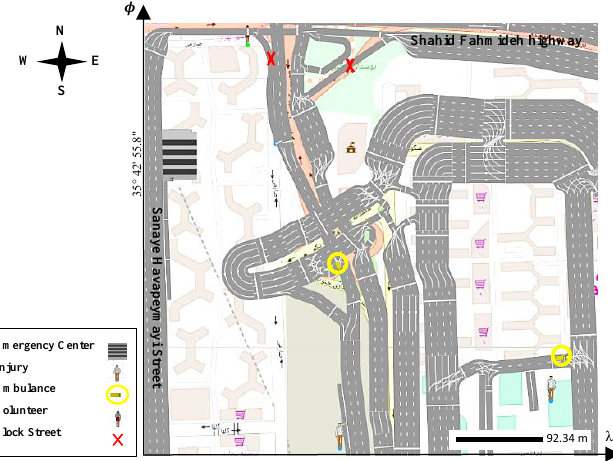
Figure 6. Implementation of the proposed multi-agent simulation for EC 2 Voronoi dagram in Anylogic